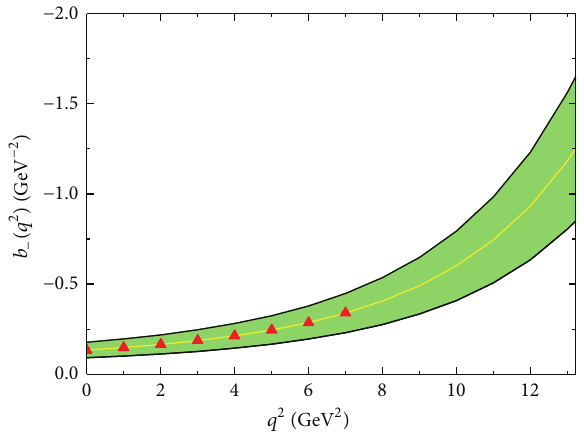
Figure 3: 𝐾(𝑞 2 ) as a function of 𝑞 2 at 𝑠 0 = 106 GeV 2 , 𝑠 󸀠 0 = 44 GeV 2 , 𝑀 2 = 17 GeV 2 , and 𝑀 󸀠2 = 10 GeV 2 . The red triangles show the QCD sum rule predictions, yellow-solid line denotes the prediction of fit function obtained using the central values of the input parameters, and the green band shows the uncertainty due to errors of input parameters.